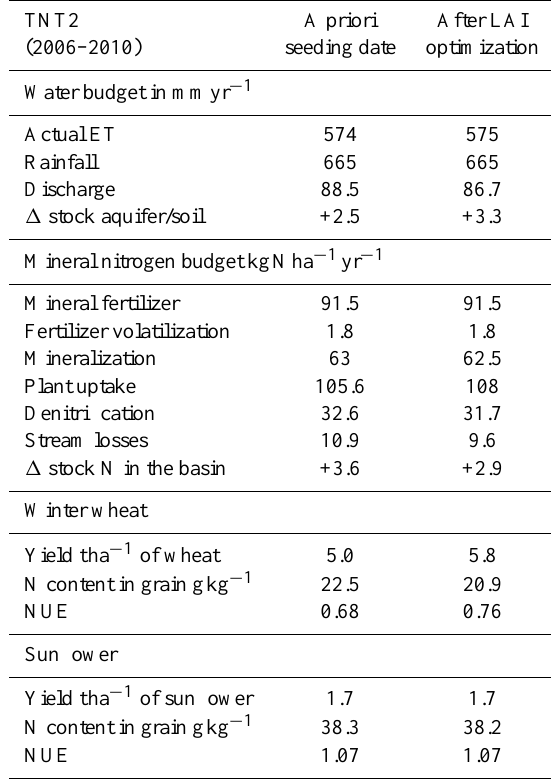
Table 1. Yearly water and N balance simulated in TNT2 model for a priori and re-set seeding date.